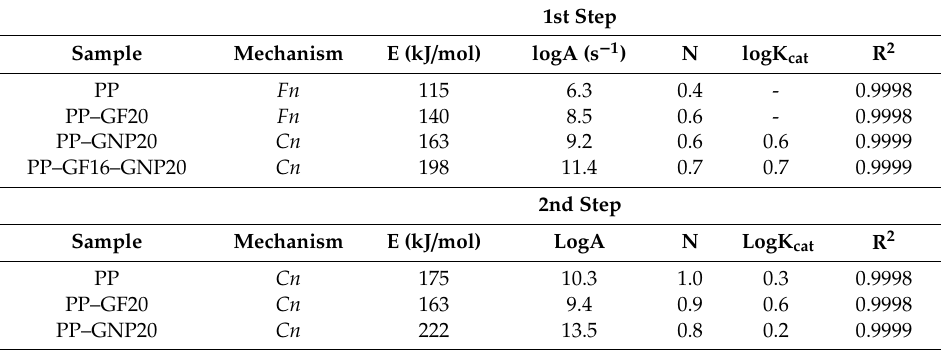
Table 1. Calculated values of activation energy (E), pre-exponential factor (A), reaction order (n), branching rate constant (K cat ) and correlation coe ffi cient (R 2 ) for PP and the composites. 1st